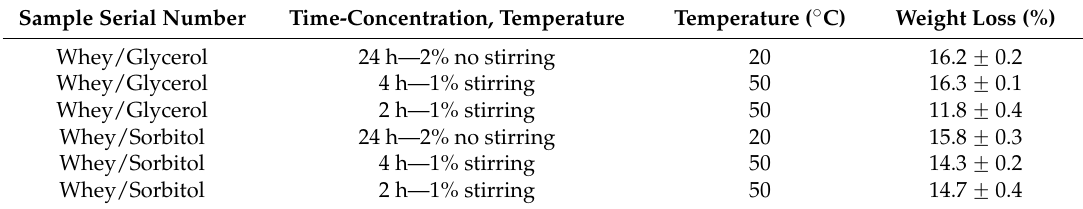
Table 1. Weight loss in PET samples coated with whey and treated with Terg-a-Zyme. Sample Serial